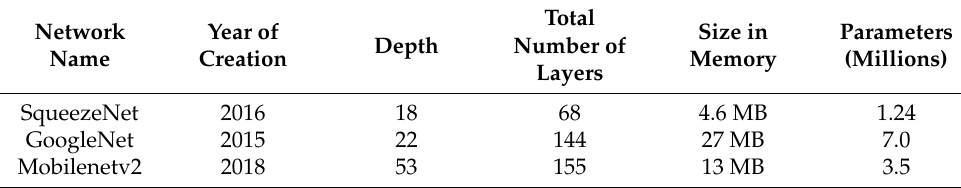
Table 1. Main small CNN networks for its use in the RCNN